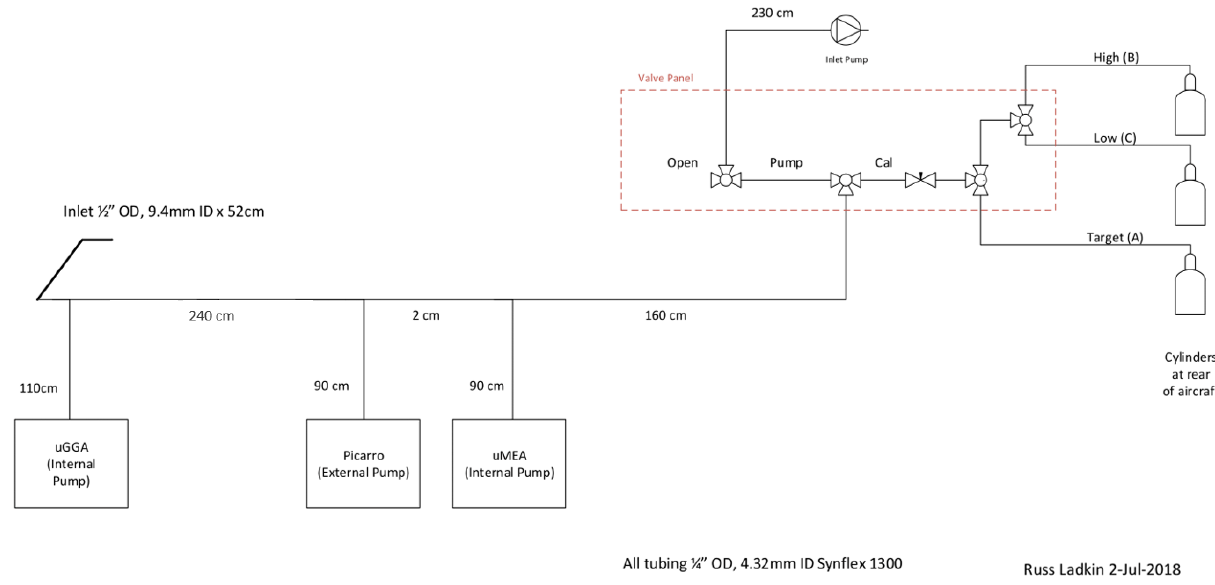
Figure 2. Layout of the plumbing of the calibration system (and inlet system) for the 2018